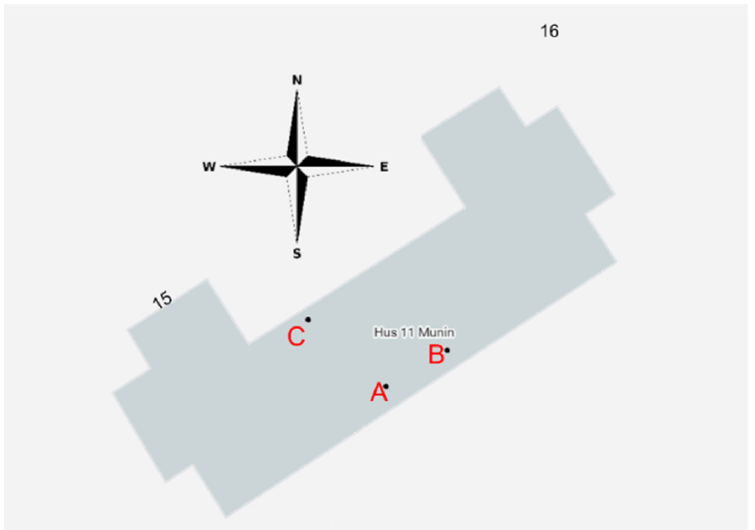
measurements were taken, and they are listed in Table 3.